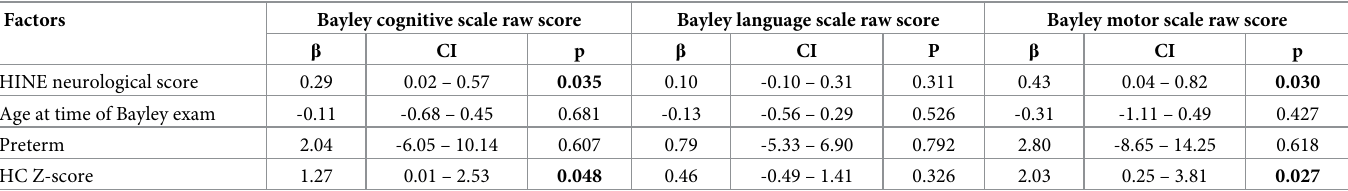
Table 2. Linear regression, factors associated with Bayley-III raw scores in children with microcephaly associated with the Congenital Zika Syndrome.